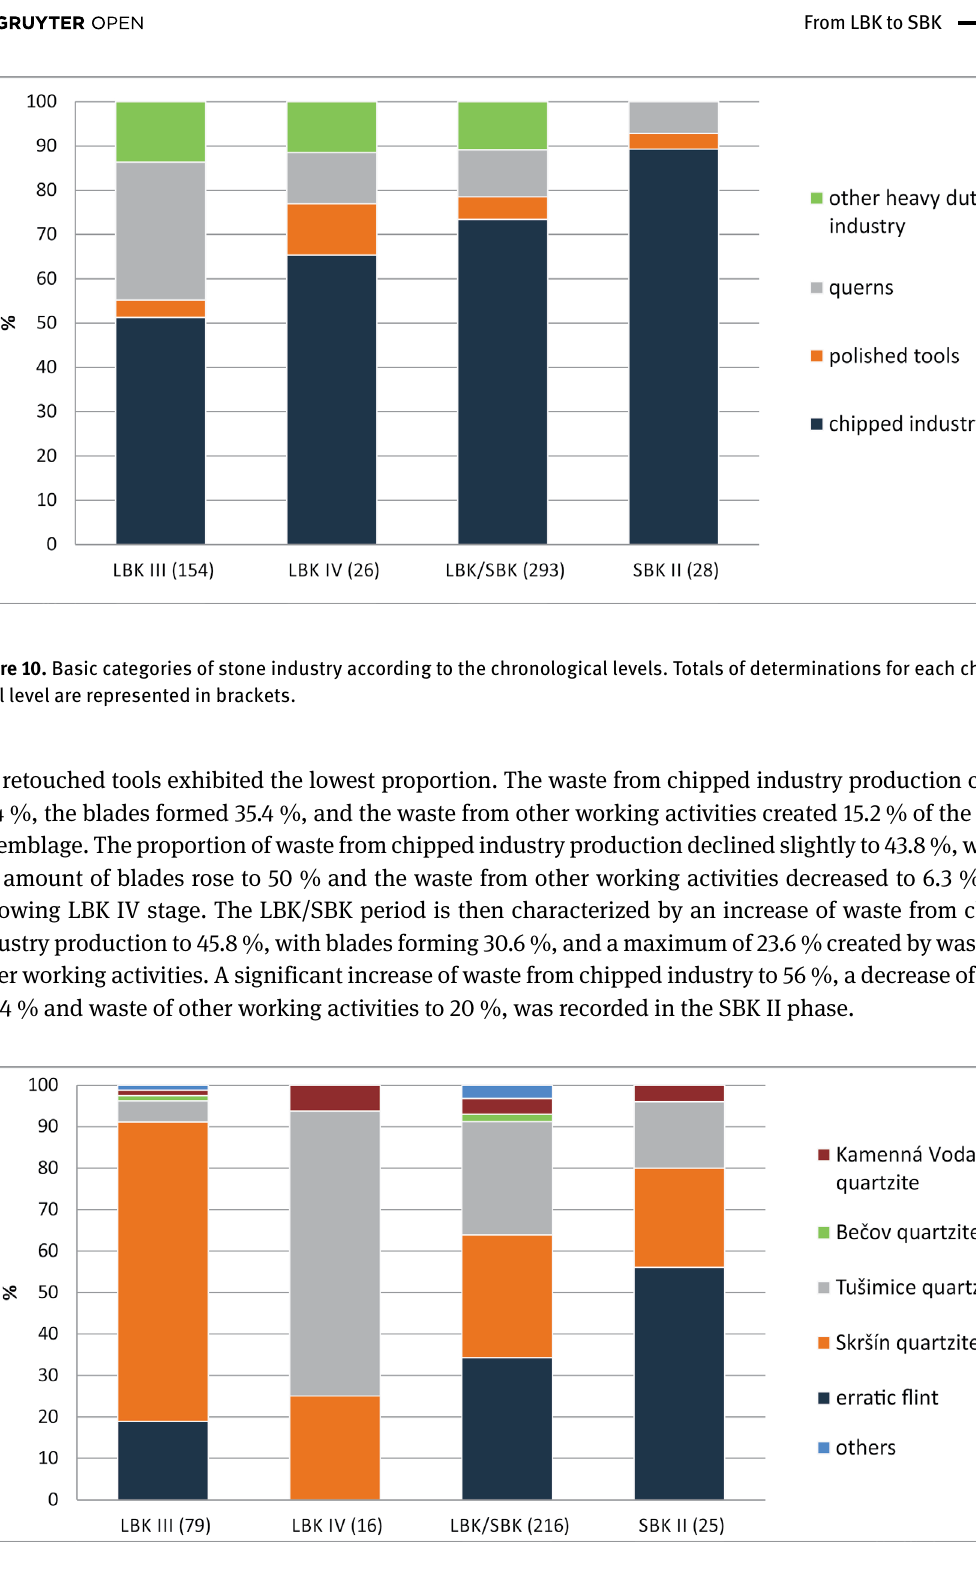
Figure 11. Percentage representation of raw materials used for chipped stone industry production according to the chronologi- cal levels. Totals of determinations for each chronological level are represented in brackets.